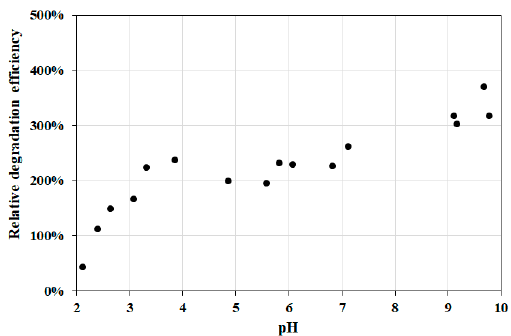
Figure 12. Effect of pH on the relative degradation efficiency of MB degradation. Concentrations: NP-3 = 400 mg/L, conc. of MB = 1.5 × 10 − 5 mol/L, and conc. of H 2 O 2 = 1.76 × 10 − 1 mol/L.